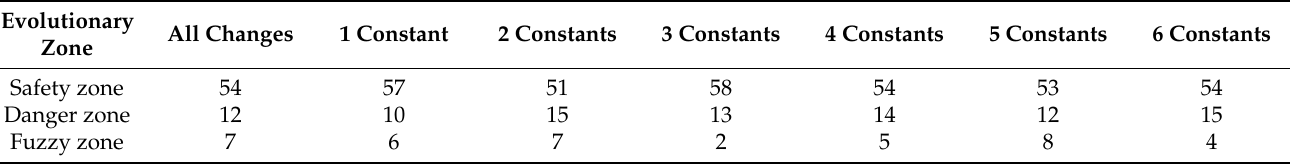
Table 6. Quantitative relationship of evolutionary zone